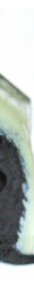
Figure 7. Photograph of solidified MCF rubber without MF.